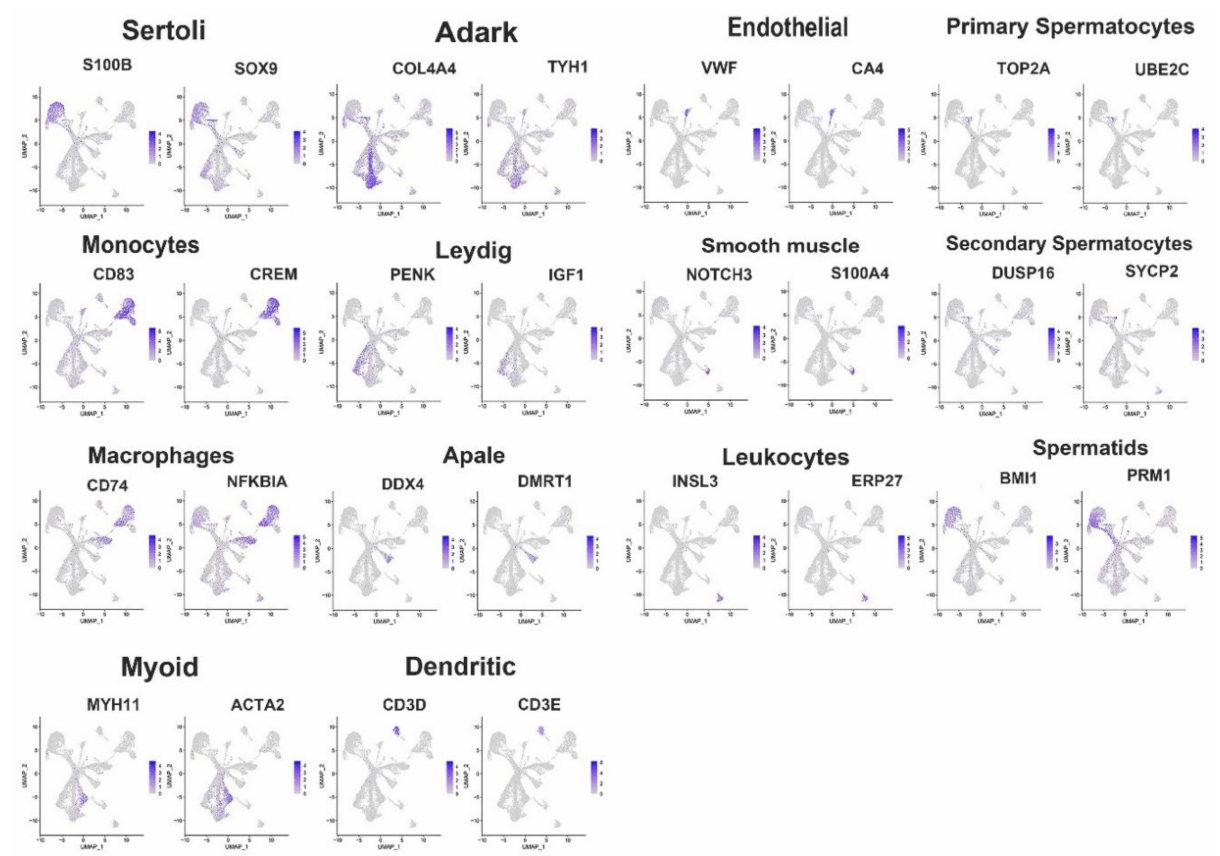
Figure 1. Sheep testicular cell classification and cell type identification. The expression patterns of the known marker genes projected on the UMAP plot. The colors from blue to gray represent the expression levels from high to